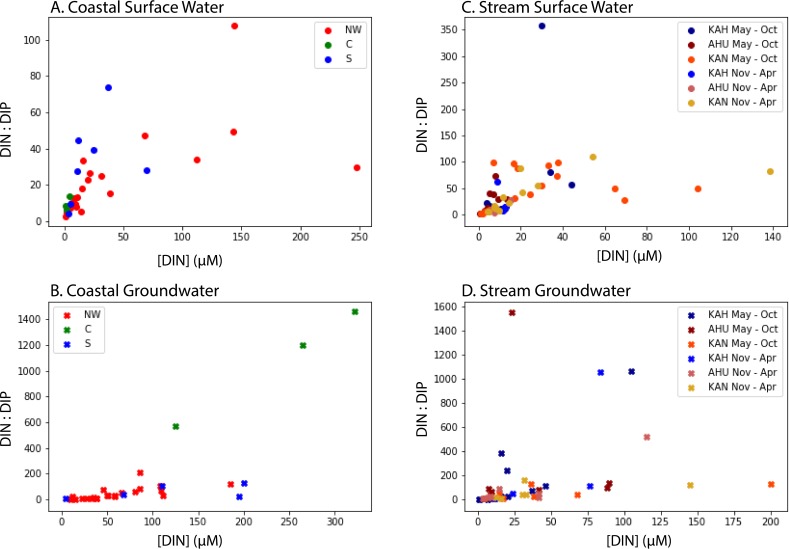
Salinity corrected DIN: DIP ratios vs. DIN concentrations by sector/sub-watershed, sampling period, and type of water.(A) Coastal surface water and (B) coastal groundwater, color-coded by NW, C, and S sectors. (C) Stream surface water and (D) stream groundwater, color-coded by sub-watershed: Kahaluʻu (KAH), ʻĀhuimanu (AHU), and Kāneʻohe (KAN) and sampling period.